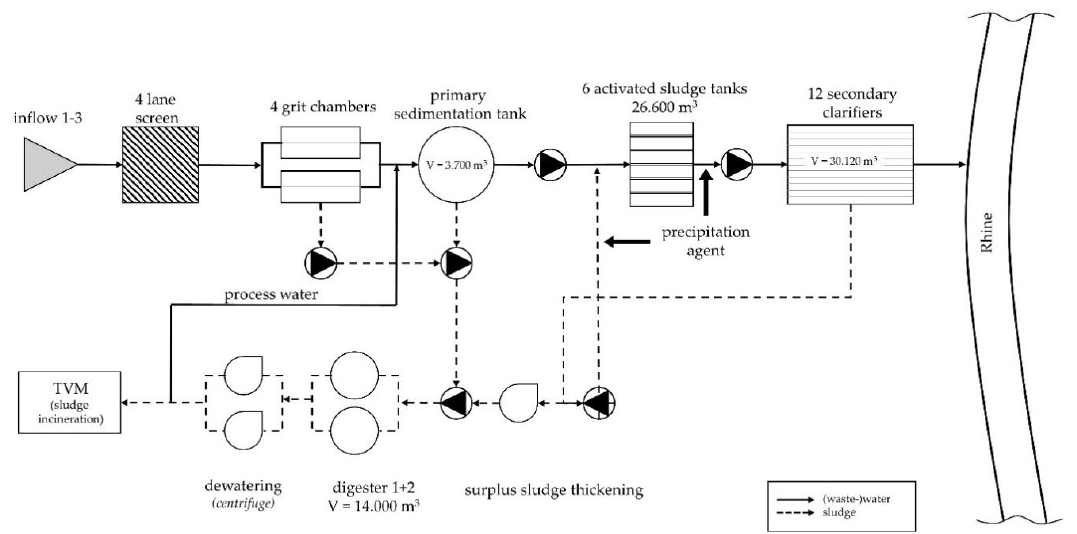
Figure 1. Simplified flow chart of the wastewater treatment plant (WWTP) Mainz.